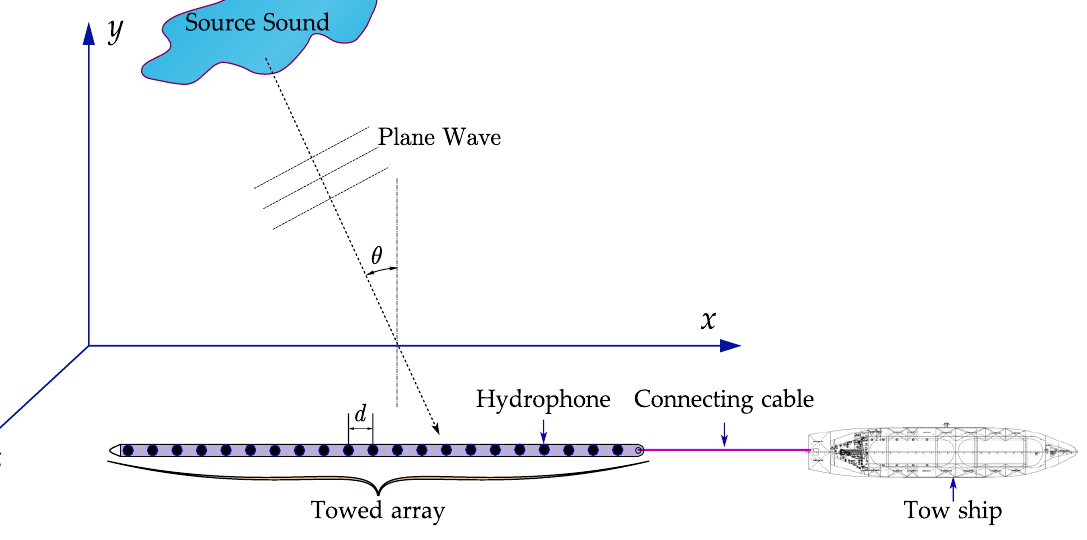
Figure 1. Schematic diagram of a towed array sonar.